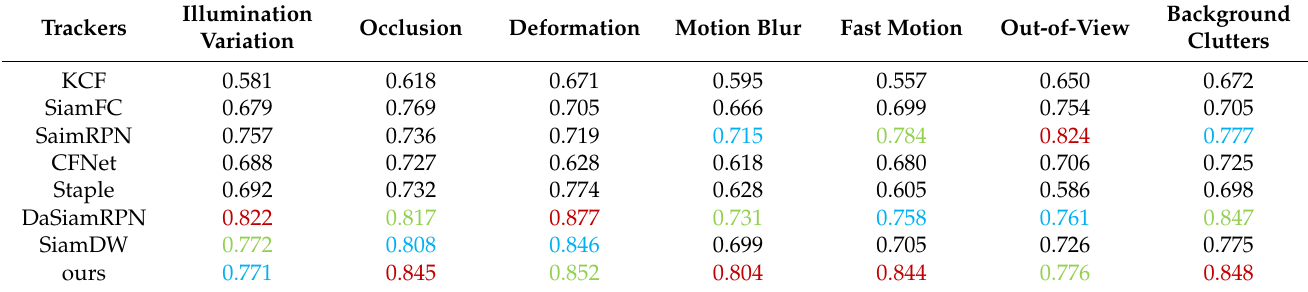
Table 2. Precision under di ff erent a tt ributes. The best three results are marked in red, green, and Table 3. Success under different attributes. The best three results are marked in red, green, and blue blue bold fonts, respectively. bold fonts,